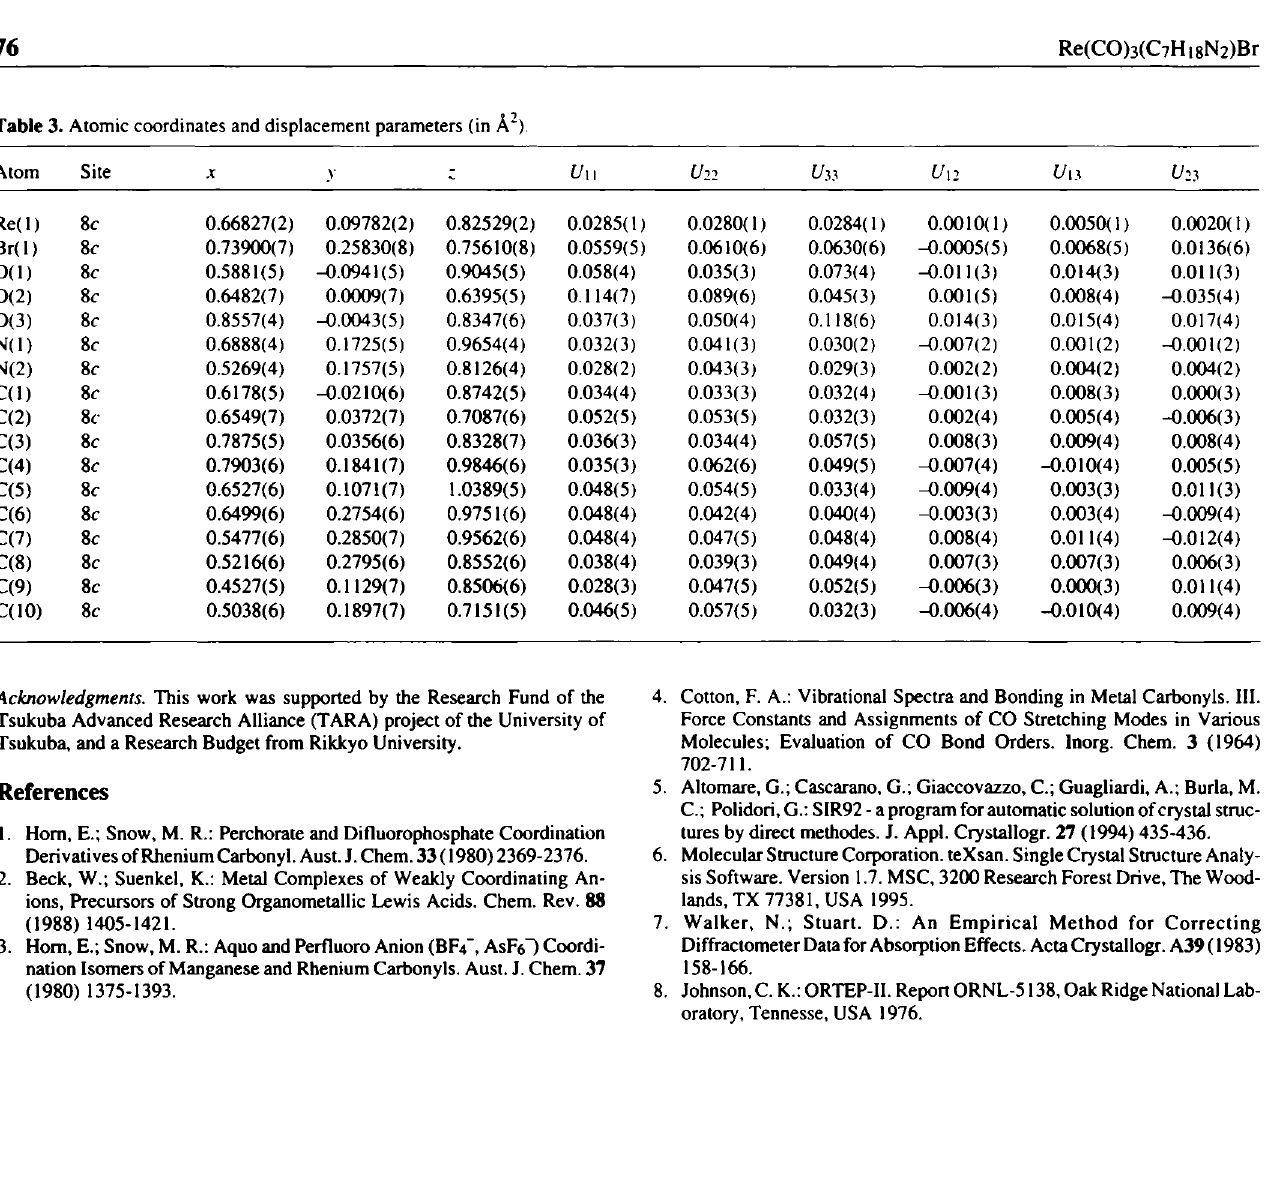
Table 3. Atomic coordinates and displacement parameters (in